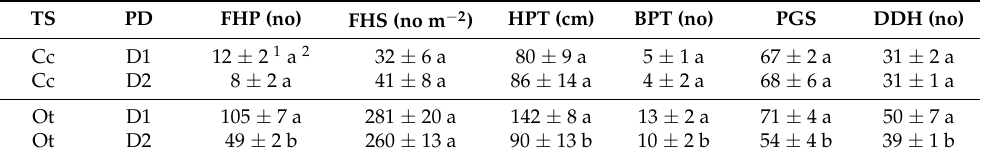
Table 5. Estimated biometric marginal mean differences calculated with the Bonferroni adjustment between the compared